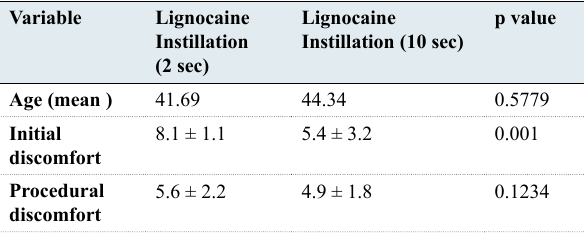
Table 2: Comparison of initial and procedural discomfort between lignocaine instilled in 2 seconds vs. 10 seconds